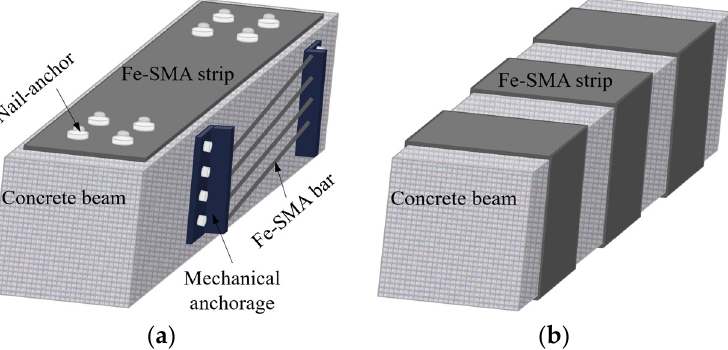
Figure 17. External installation modes: ( a ) mechanical connection, ( b ) surrounding beam surface.